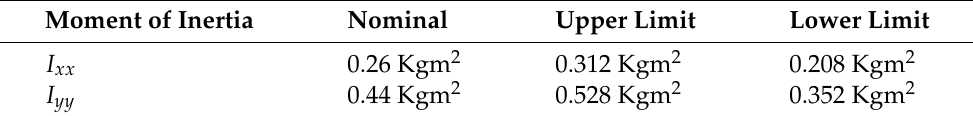
Table 4. Ranges of uncertainties considered in the moments of inertia of the